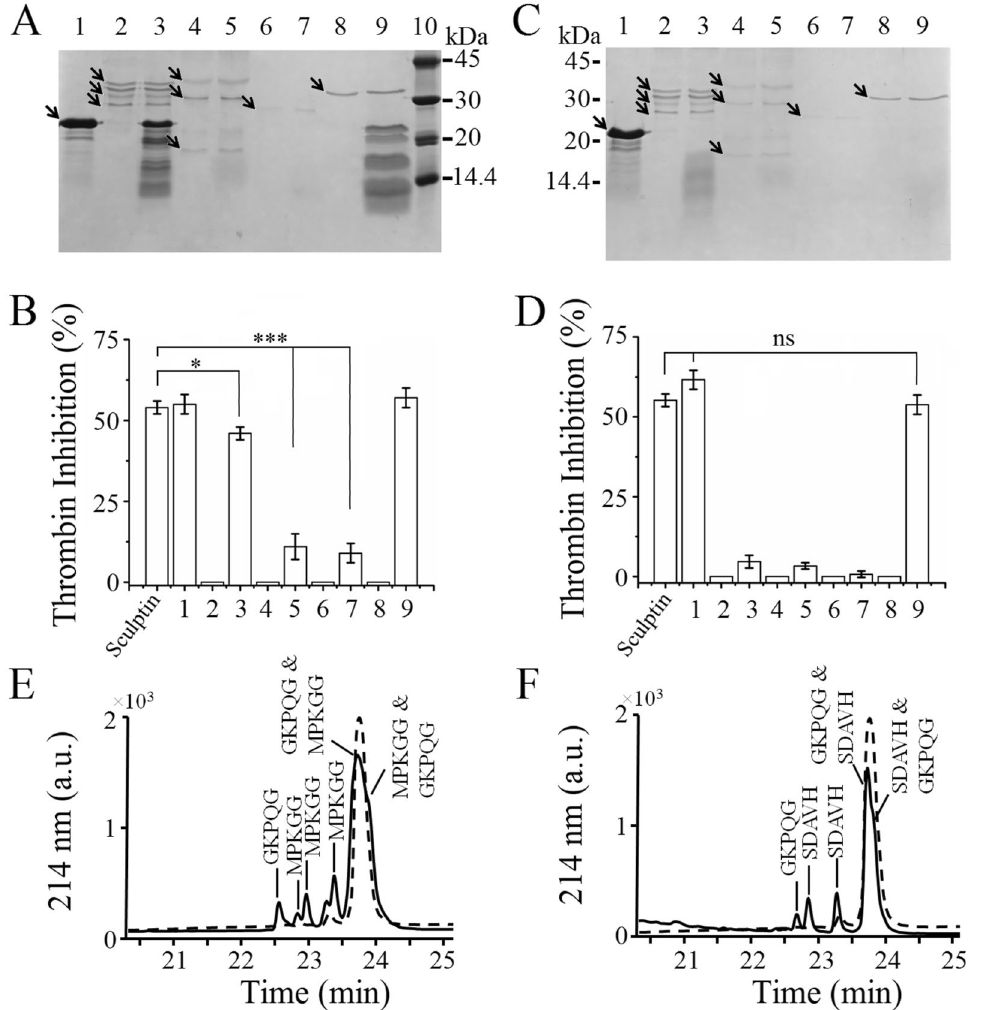
Figure 5. Degradation of sculptin by serine proteases and its thrombin inhibition activity. Sculptin (10 µ M) was incubated without or with 1 µ M of serine protease (thrombin, plasmin, trypsin or factor Xa) in 50 mM phosphate buffer containing 150 mM NaCl and 0.1% PEG 6000, pH 7.4 for 4, 6, 7 or 18 h at 37 °C. The reaction mixtures (20 µ l) were separated by SDS-PAGE. ( A ) SDS-PAGE (15%) of sculptin hydrolysis by serine proteases after 6 h incubation. ( B ) Percent thrombin inhibition by sculptin after 6 h incubation with serine proteases (see experimental procedures). ( C ) SDS-PAGE (15%) of sculptin hydrolysis by serine proteases after 18 h incubation. ( D ) Percent thrombin inhibition by sculptin after 18 h incubation with serine protease (see experimental procedures). The numbering of ( B ) and ( D ) correspond to the numbering of ( A ) and ( C ) respectively and sculptin control is represented by CTRL. Sculptin (lane 1); thrombin (lane 2) and thrombin with sculptin (lane 3); plasmin (lane 4) and plasmin with sculptin (lane 5); trypsin (lane 6) and trypsin with sculptin (lane 7); factor Xa (lane 8) and factor Xa with sculptin (lane 9) and protein marker (lane 10; in A). ( E ) Identification of thrombin cleavage sites in sculptin after 7 h of incubation. ( F ) Identification of factor Xa cleavage sites in sculptin after 4 h of incubation. Thrombin and Factor Xa cleavage sites in sculptin sequence are given in Figs S1 and S2 respectively. The experimental procedure for ( C – E ) and ( F ) was same for ( A ) and ( B ) except incubation time and type of serine protease used. The results shown in ( B ) and ( D ) correspond to the mean ± standard deviation values acquired in three independent experiments; ns nonsignificant, *** p < 0.001 and * p <